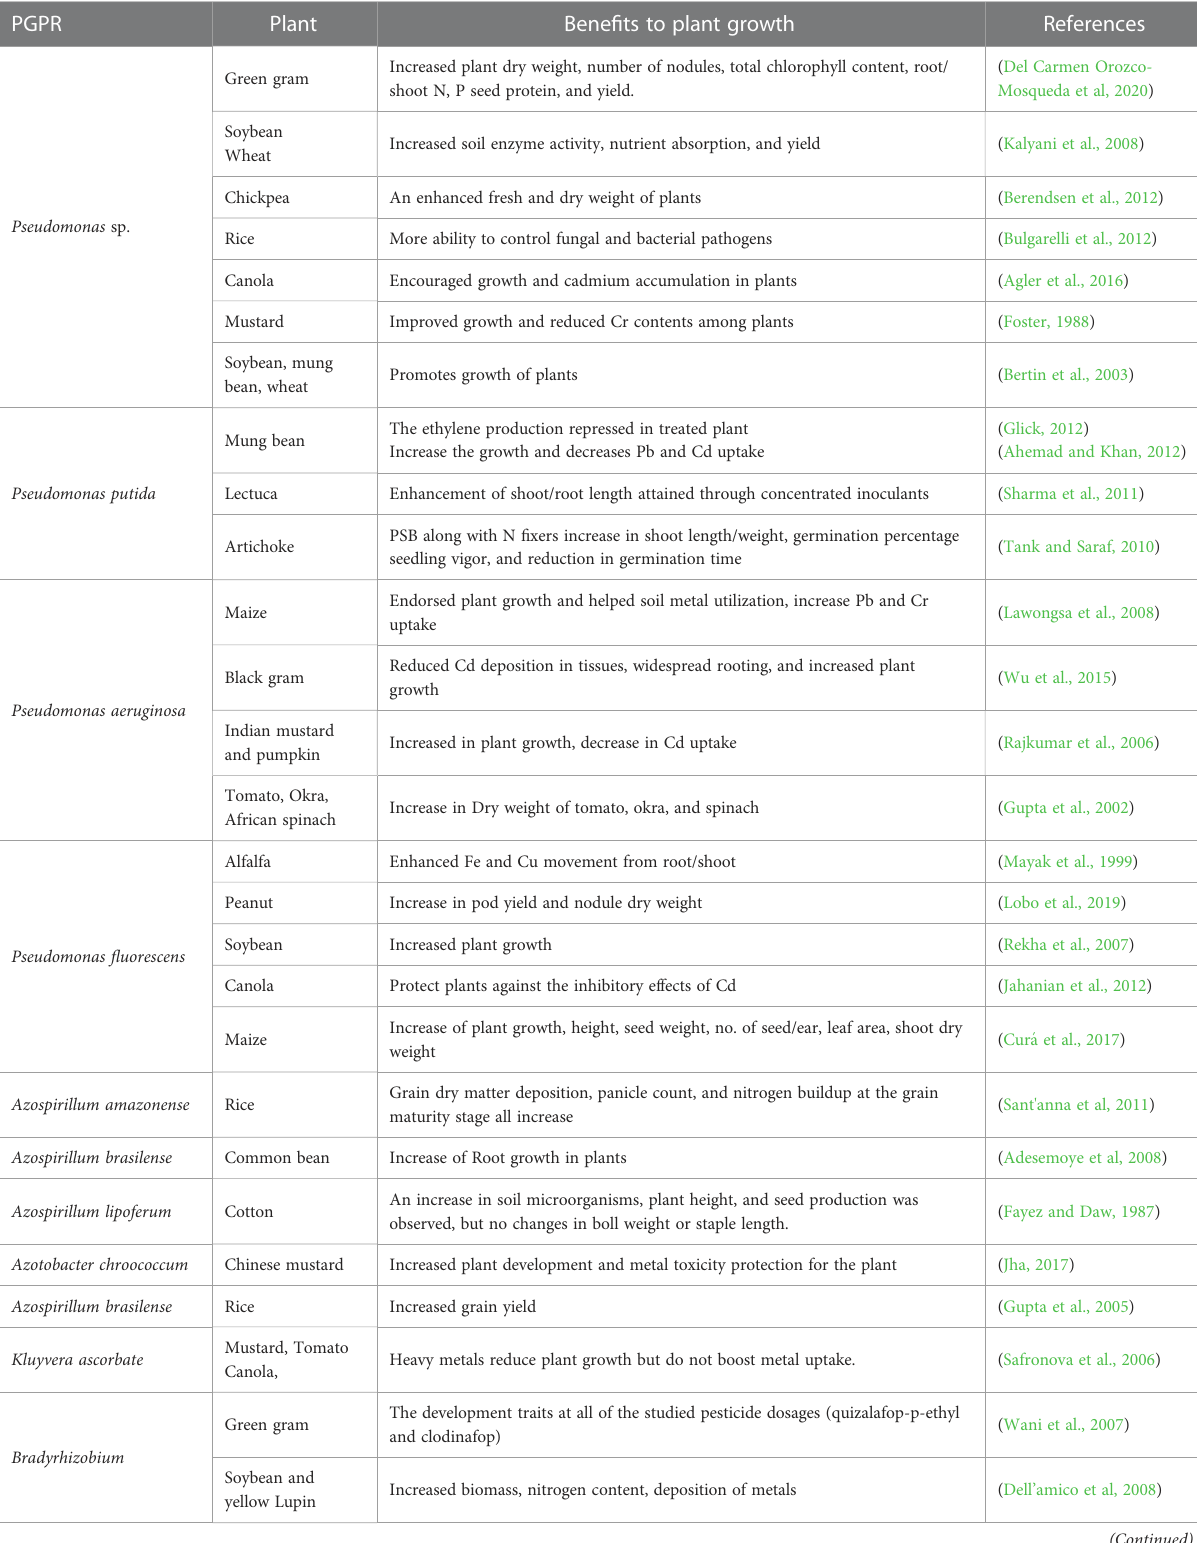
TABLE 1 Examples of plant growth-promoting rhizobacteria tested for various crop types.